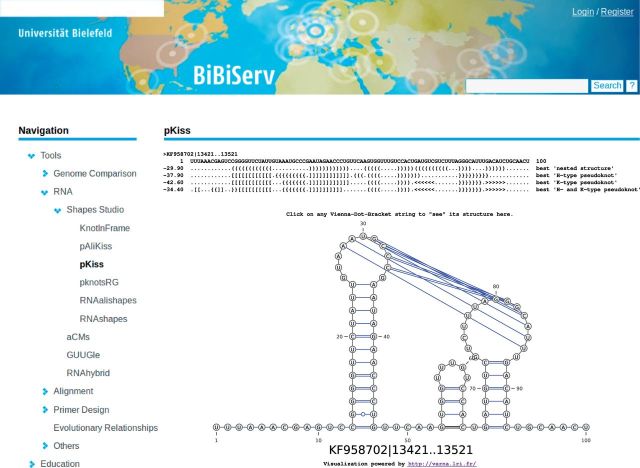

RNA shapes studio result page for folding the MERS example with
p
K
iss
. Illustration by VARNA (

Darty
et al.
, 2009

)